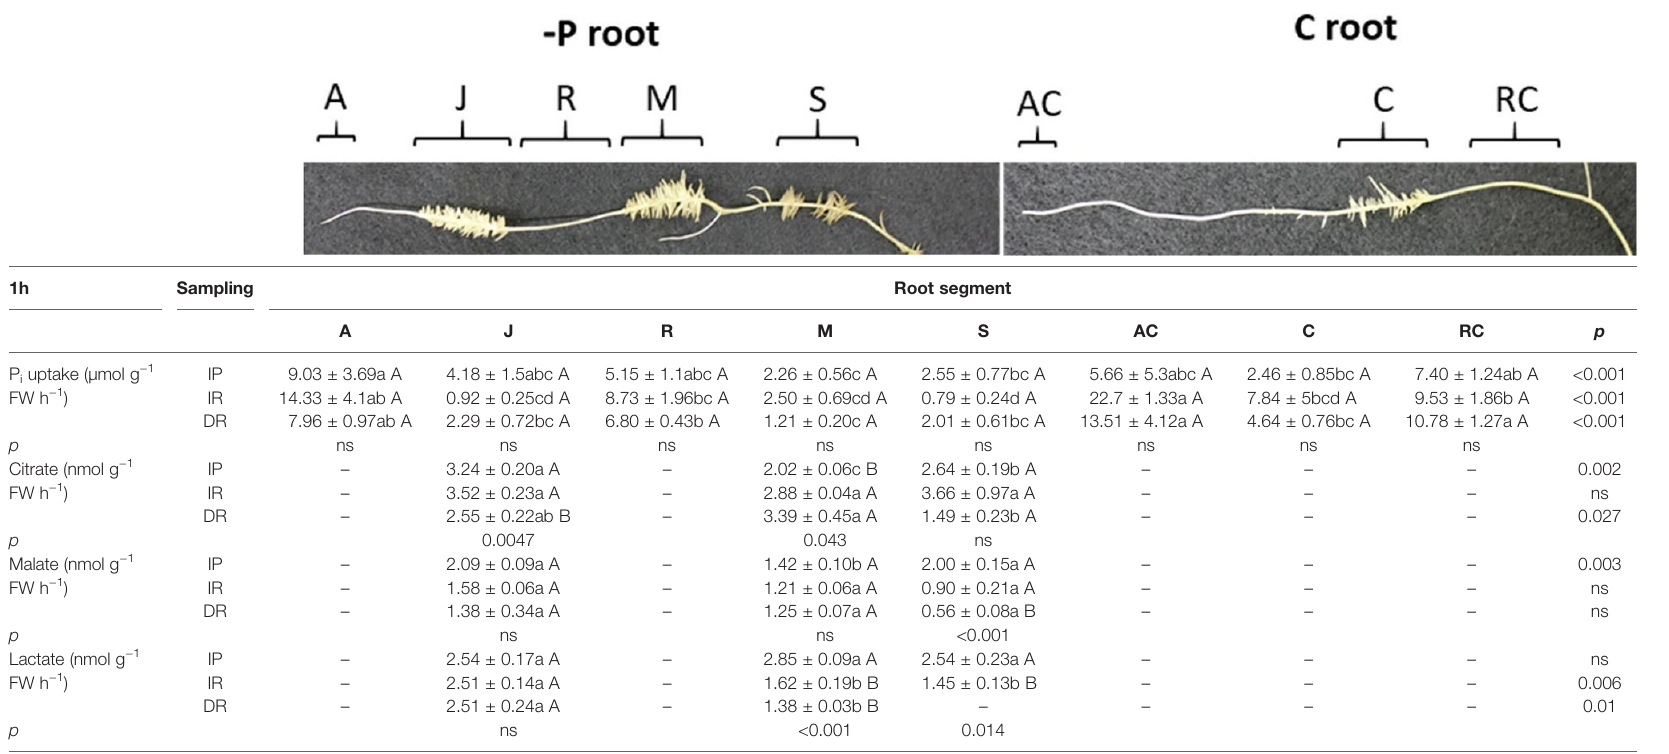
PhosphateuptakeratehasbeencalculatedbydifferencebetweentheconcentrationofPO 43 − beforeandafterthecontacttimesofrootswiththeuptakesolution.-Prootshavebeenseparatedin fi vedifferentrootsegments:A,apex;J,juvenile cluster root; R, root; M, mature cluster root; S, senescent cluster root; C roots have been separated in three different root segments: AC, apex control; C, cluster control; RC, root control. Phosphate uptake and carboxylate exudation have beendeterminedusingthreedifferentroothandlings:IP,intactplants;IR,intactroots;DR,dissectedroots.Dataarepresentedasmean±SE,n=5.Lowercaselettersindicatestatisticalsigni fi cancebetweendifferentrootsegments(i.e.AvsJ) within the same root handling method according to one-way ANOVA comparing means by Holm-Sidak post hoc test with a signi fi cance threshold at p < 0.05. Upper case letters indicate statistical signi fi cance within the same root segments but different sampling methods (i.e. IP vs IR) according to one-way ANOVA comparing means by Holm-Sidak post hoc test with a signi fi cance threshold at p < 0.05; ns, non-signi fi